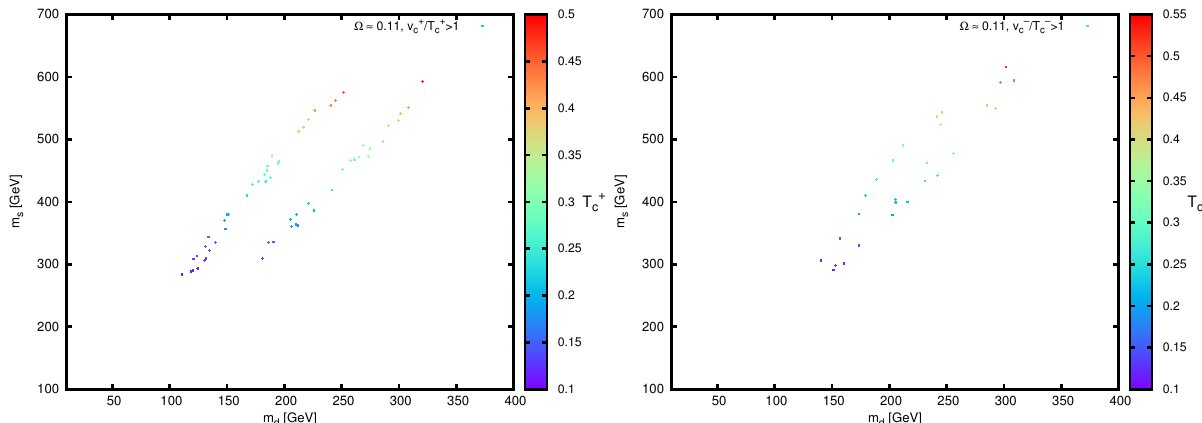
Figure 4 . The pseudoscalar mediator mass against the allowed DM mass for left) T + right) T (cid:0) solution. The critical temperature is shown in the color c